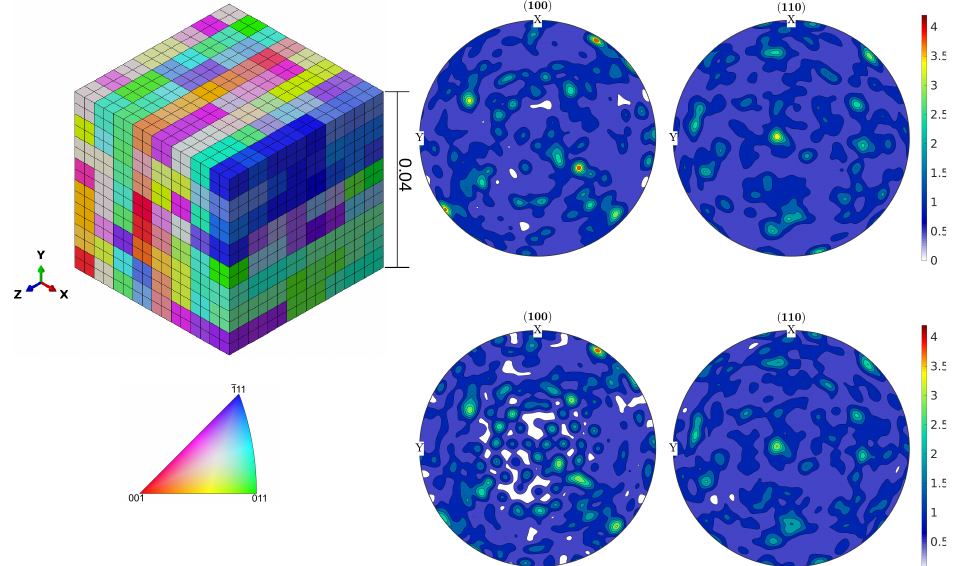
Figure 5. ( top left ) Graphical representation of the used RVE with 512 cubic grains and 8 finite elements per grain, ( bottom left ) grains are colored according to their orientation and the corresponding IPF key. Contour plots of the ODF pole figures from the orientation set obtained by combining all the EBSD data sets of about 19,000 grains ( top right ) and 512 discrete orientations in the RVE ( bottom right